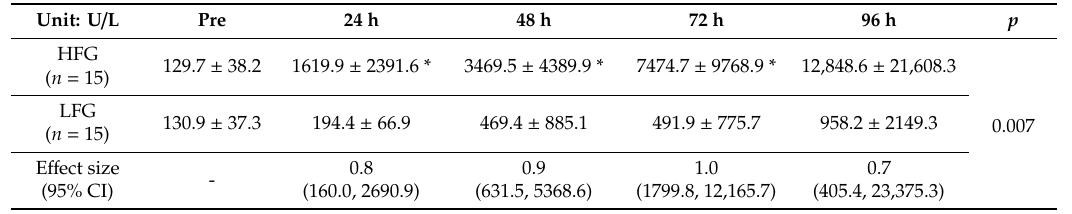
Table 5. CK after eccentric exercise according to %fat.